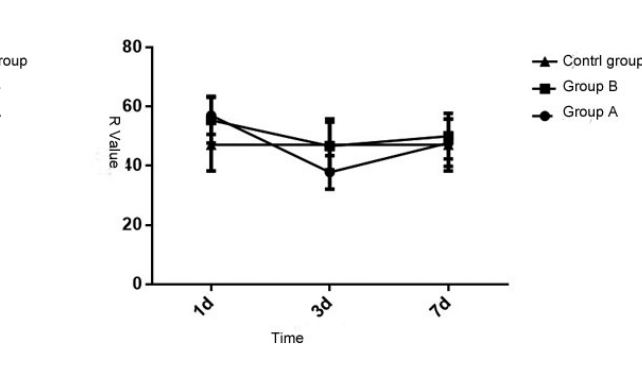
Figure 4: Comparative analysis of ma value of the patients in the three groups at different